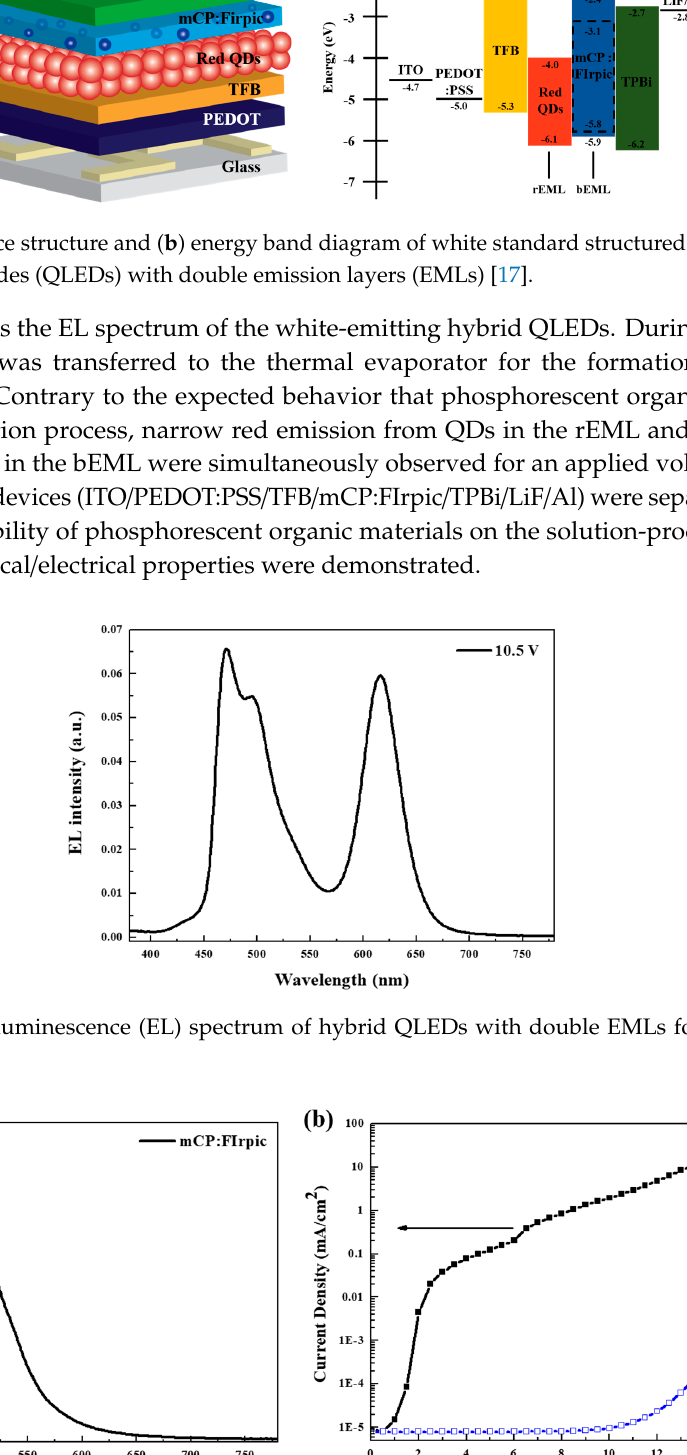
Figure 3. ( a ) EL spectrum and ( b ) current density–luminance with applied voltage of OLEDs with 1,3- Bis(carbazol-9-yl)benzene (mCP): bis[2-(4,6-difluorophenyl)pyridinato-C2,N]iridium(III) (FIrpic) as an EML.